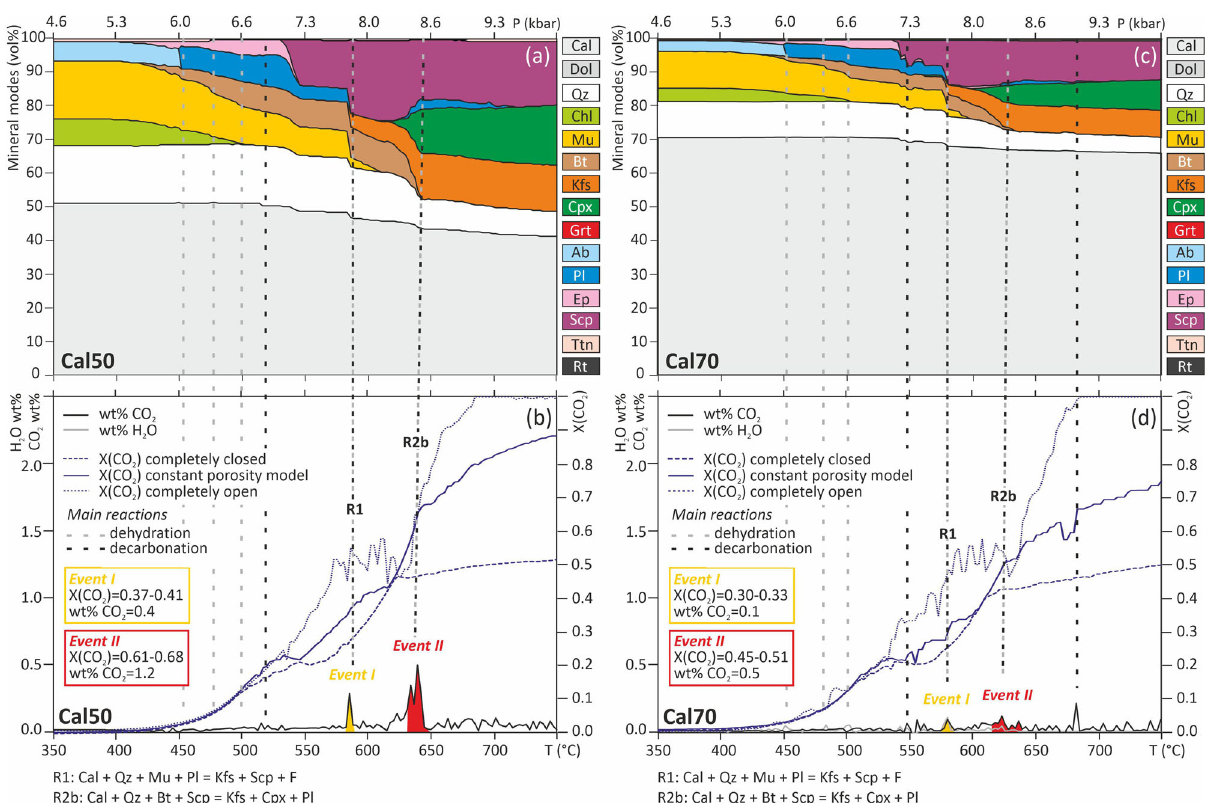
Fig. 2 Modal variations and wt% of CO 2 and H 2 O released during prograde metamorphism of Cal50 and Cal70 bulk compositions. a , c Mode box changes in calculated mineral proportions (vol%, fl uid excluded) during prograde metamorphism of sediments initially containing ( a ) 50 vol% of calcite (Cal50) and ( c ) 70 vol% of calcite (Cal70) along the modeled internally buffered P/T – X (CO 2 ) paths. b , d Loss (wt%) of CO 2 (black line) and H 2 O (gray line) relative to the initial CO 2 and H 2 O content in the solids, and X (CO 2 ) of the fl uid (blue lines) released during prograde metamorphism of Cal50 ( b ) and Cal70 ( d ), along the same internal buffered P/T – X (CO 2 ) path as in ( a ) and ( c ). Events I (yellow) and II (red) refer to the main events of CO 2 production, as discussed in the text. Dashed lines highlight the main dehydration and decarbonation reactions, corresponding to abrupt consumption and/or complete disappearance of hydrous and CO 2 -bearing minerals. Reactions corresponding to the event I (R1) and event II (R2b) are speci fi